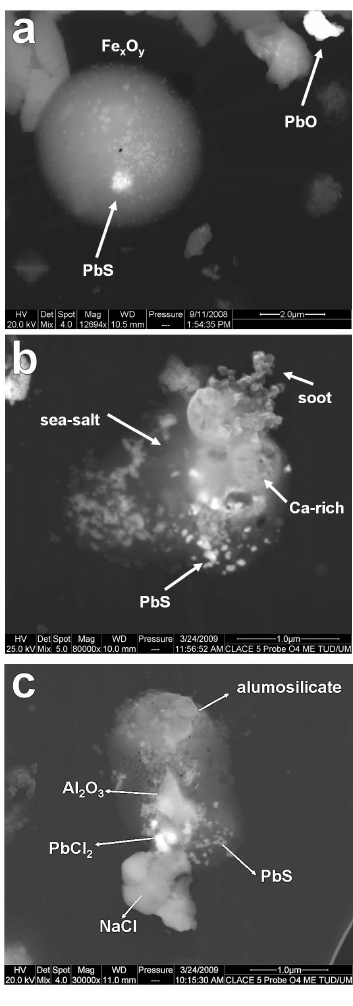
Fig. 3. Mixed secondary/backscatter electron images of Pb-bearing particles.